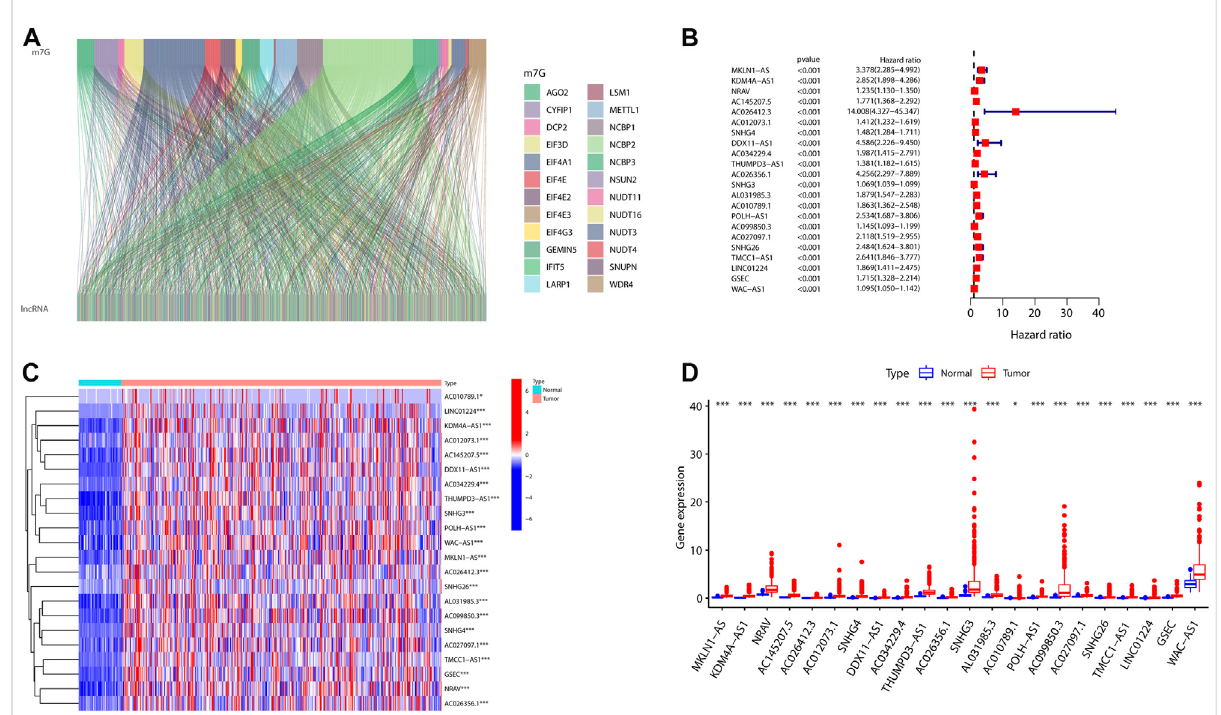
FIGURE 1 Expression pro fi les of m7G-related genes in patients with HCC. (A) Sankey for m7G-related genes and m7G-related lncRNAs. (B) Forest plot of 22 prognostic m7G-related lncRNAs. (C,D) Heatmap (C) and expression (D) of 22 m7G-related lncRNAs in the TCGA set. (* p < 0.05; *** p < 0.001). m7G, N7-methylguanosine; HCC, hepatocellular carcinoma; lncRNAs, long non-coding